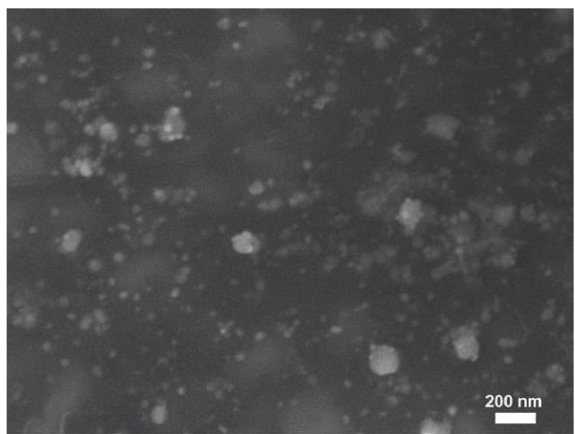
Figure 5: The FESEM image of the Ag NP powder sample coated on the SiO